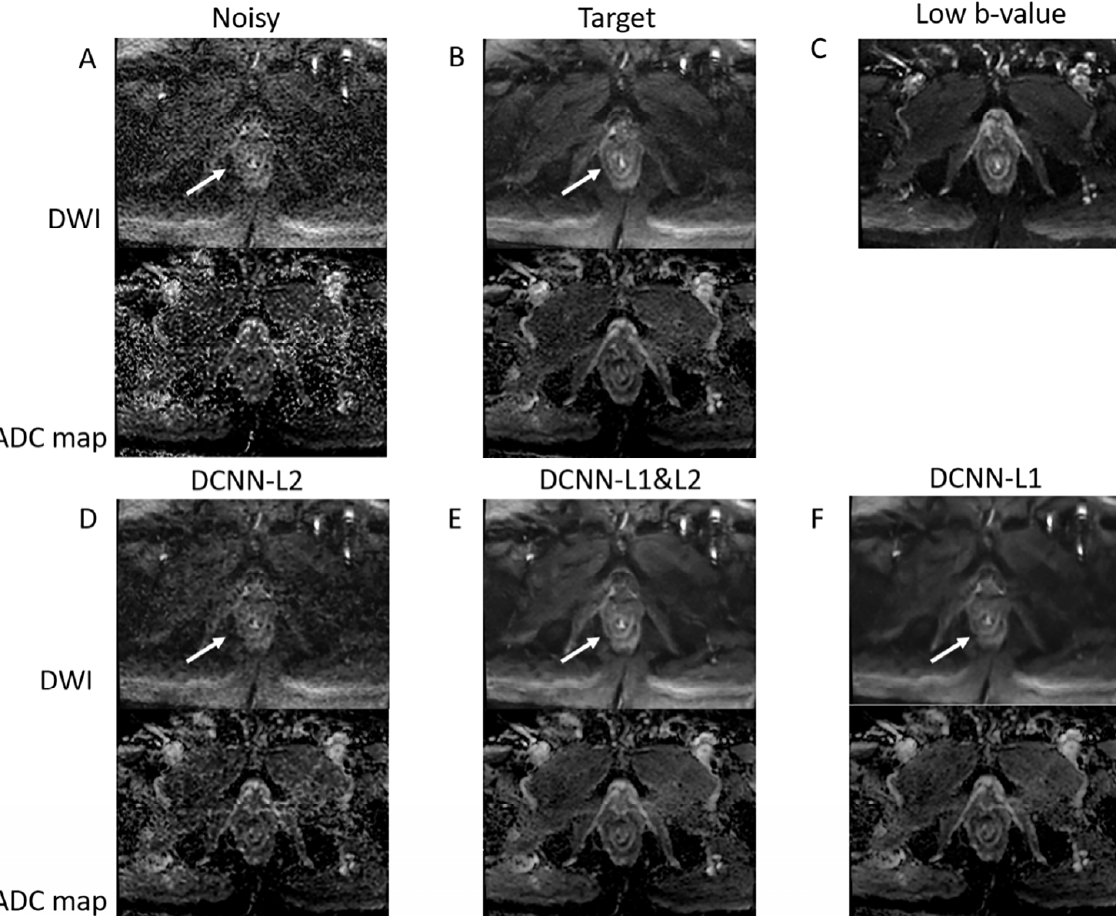
Figure 6. DCNN with different loss functions in another patient. ( A ) Noisy high b -value image reconstructed with NEX = 1 corresponding to an acquisition time of 22 s. ( B ) Target high b -value image with NEX = 16 corresponding to 370 s acquisition time. ( C ) Low b -value image used as a guide. ( D ), ( E , F ) denoised images acquired with NEX = 1 using L2, joint L1–L2, and L1 loss functions. In this case, the joint L1–L2 loss function also outperforms L1 and L2.